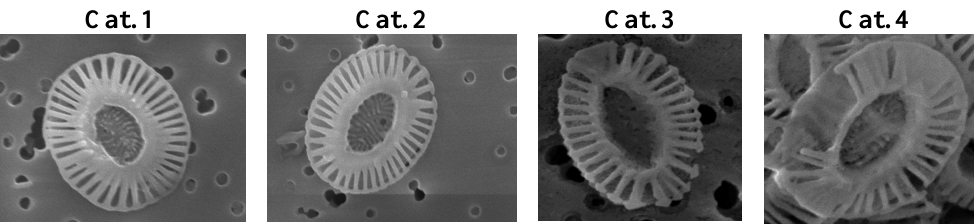
Fig. 2. Scanning electron micrographs of the four categories of coccolith morphology from normal coccoliths (cat. 1) to fragmented coccol- iths (cat. 4).